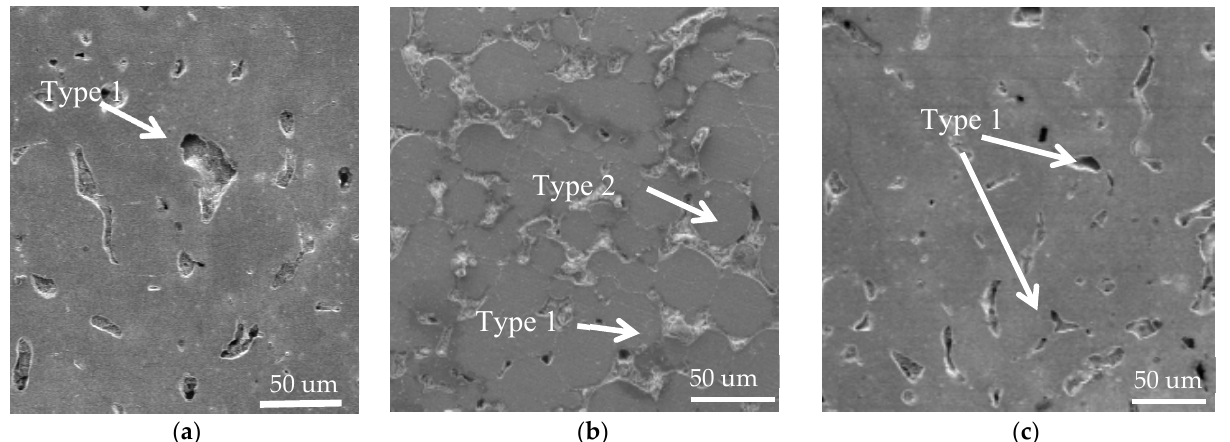
Figure 9. Surface morphology of the alloy ( a ) Mg-0.5%Mn-2%Zn, ( b ) Mg-1%Mn-2%Zn, and ( c ) Mg-1.5%Mn-2%Zn .